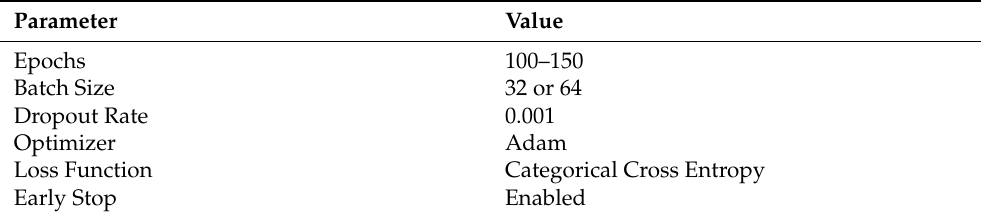
Table 2. Table 2. Parameters used during model training.